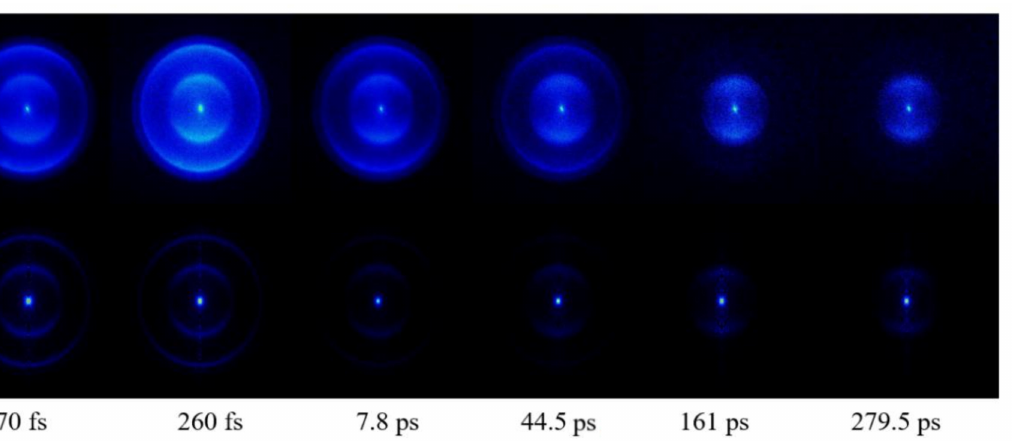
Figure 2. Time-resolved raw photoelectron images ( upper row ) and BASEX-inverted images ( lower row ) at various time delays between the 260 nm pump and 400 nm probe